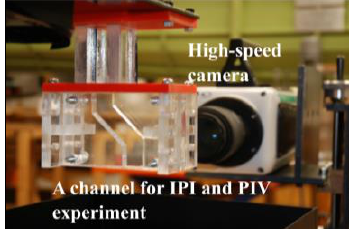
Fig. 9. The detail of an experiment setup for IPI and PIV veryfication measurements.